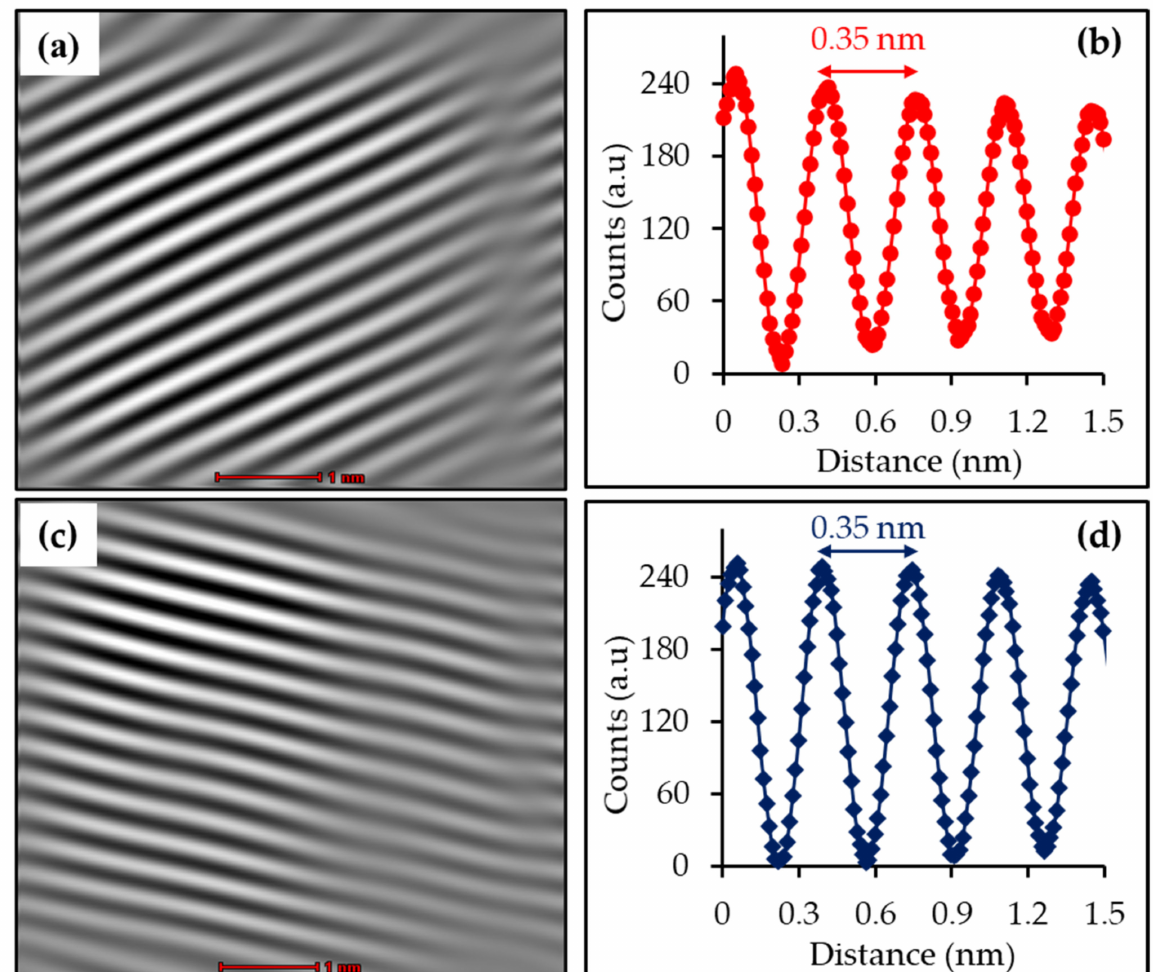
Figure 3. HRTEM images of ( a ) B-TiO 2 and ( c ) Mn-B-TiO 2 NPs and line profiles of ( b ) B-TiO 2 and ( d ) Mn-B-TiO 2